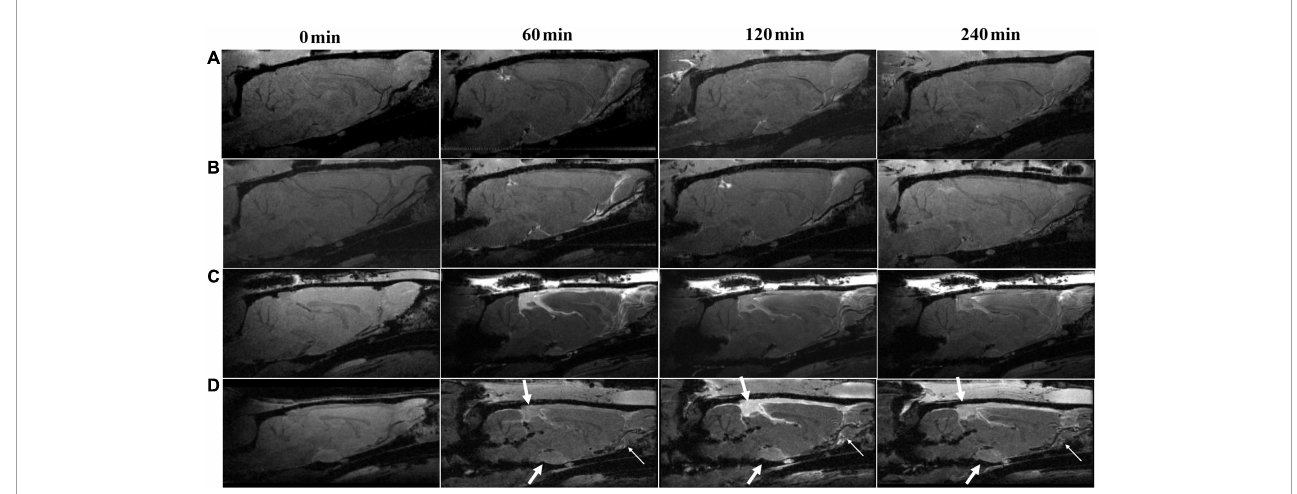
FIGURE2 Hypothermia-induced dynamic contrast concentration changes in traumatically and sham-injured brains. The time series of T1 weighted MRI images demonstrate early influx (0–60 min) and anatomic enhancement 120 min and 4 h after intrathecal injection of HA-Gd-DTPA in critical anatomical structures, including the pineal recess, pituitary recess, and olfactory artery perivascular space in Sham-NT (A) , Sham-HT (B) , TBI-NT (C) and TBI-HT (D) animal brains. As indicated by arrows, hypothermia (D) leads to delayed arrival (60 min), limited amount and extent (120 min), and reduced clean-out (240 min) of contrast agent compared with the normothermia-treated TBI (C) and sham-injured control (A,B) .